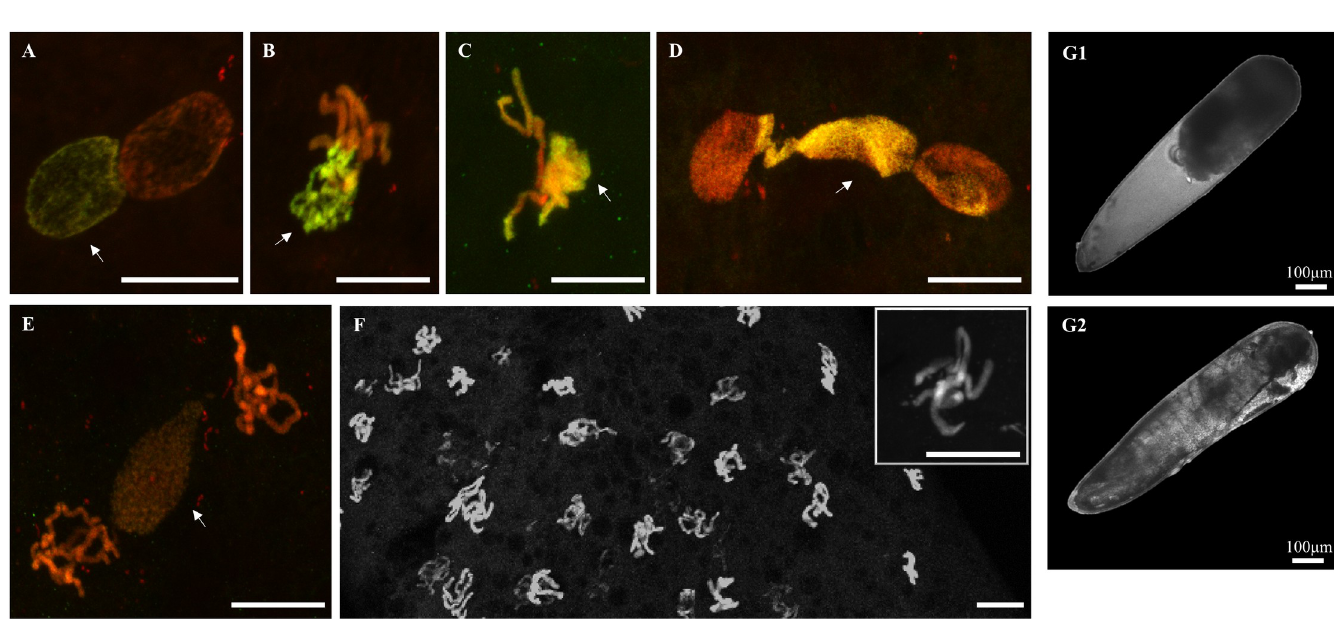
Fig 2. CI embryos from incompatible infected parents in C . pipiens : From first nuclear divisions to segmentation. Paternal chromatin appears in green/yellow (acetylated histone H4 labelling is dominant) and maternal chromatin appears in red (propidium iodide labelling is dominant) (A) apposition of maternal and paternal pronuclei, (B) delay in paternal chromatin condensation, (C) condensed maternal chromatin and under-condensed paternal chromatin, (D) paternal chromatin failed to segregate and form a chromatin bridge between segregating maternal chromatin, (E) two nuclei containing mainly maternal chromatin while paternal chromatin do not segregate, (F) haploid development 2 hours after oviposition, (G) the two possible fates of development after 48 hours (1) non-viable embryo with no visible development, and (2) unhatched developed embryo with visible segments. White arrows indicate the paternal chromatin. Confocal stacks (panels A,B,C,D,E,F) and optical images (panels G1 and G2) were obtained on embryos from several CI crosses between infected males and females due to the difficulty to obtain all the early embryonic stages for each cross (S2 Table). Green dots are background noises likely due to the presence of residual antibodies. Scale bar is 10 μ m.